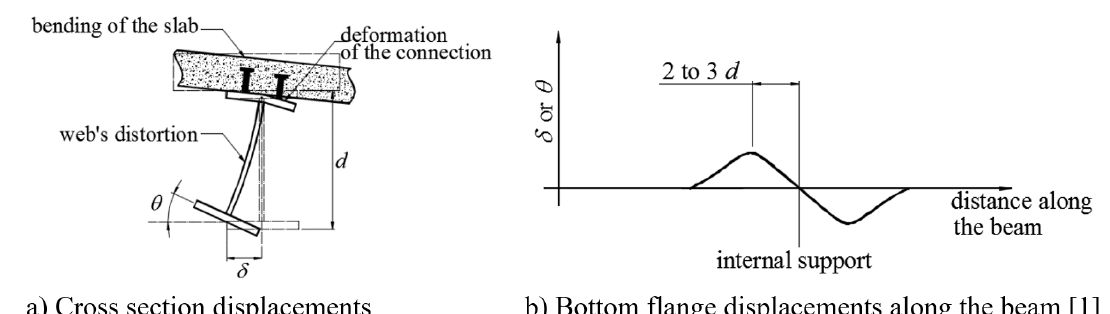
Figure 1. Lateral-torsional